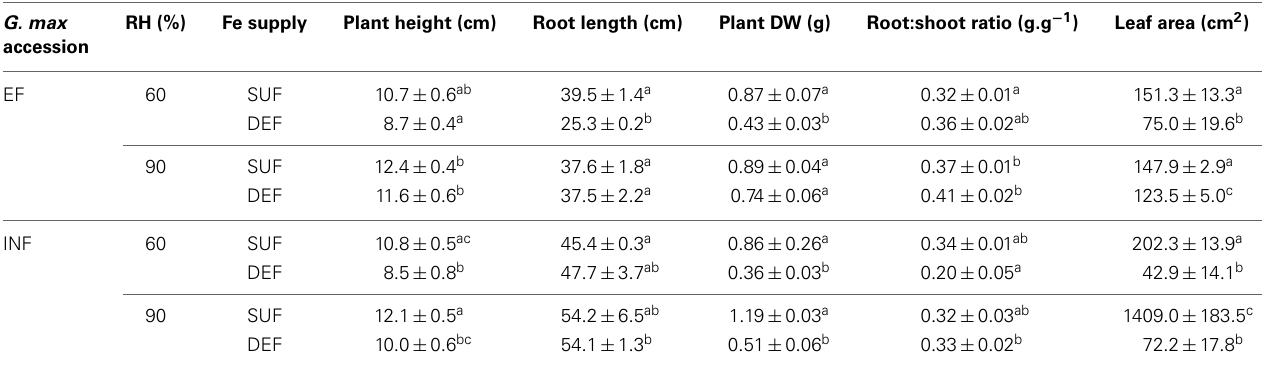
Table 1 | Plant growth of “Fe-efficient” (EF, PI 360952) and “Fe-inefficient” (INF, PI 407707) Glycine max ( G. max ) accessions measured 14 days after transfer to hydroponic conditions grown at 60% and 90% relative humidity (RH) under Fe-sufficient (SUF) and Fe-deficient (DEF) conditions (Fe supply).